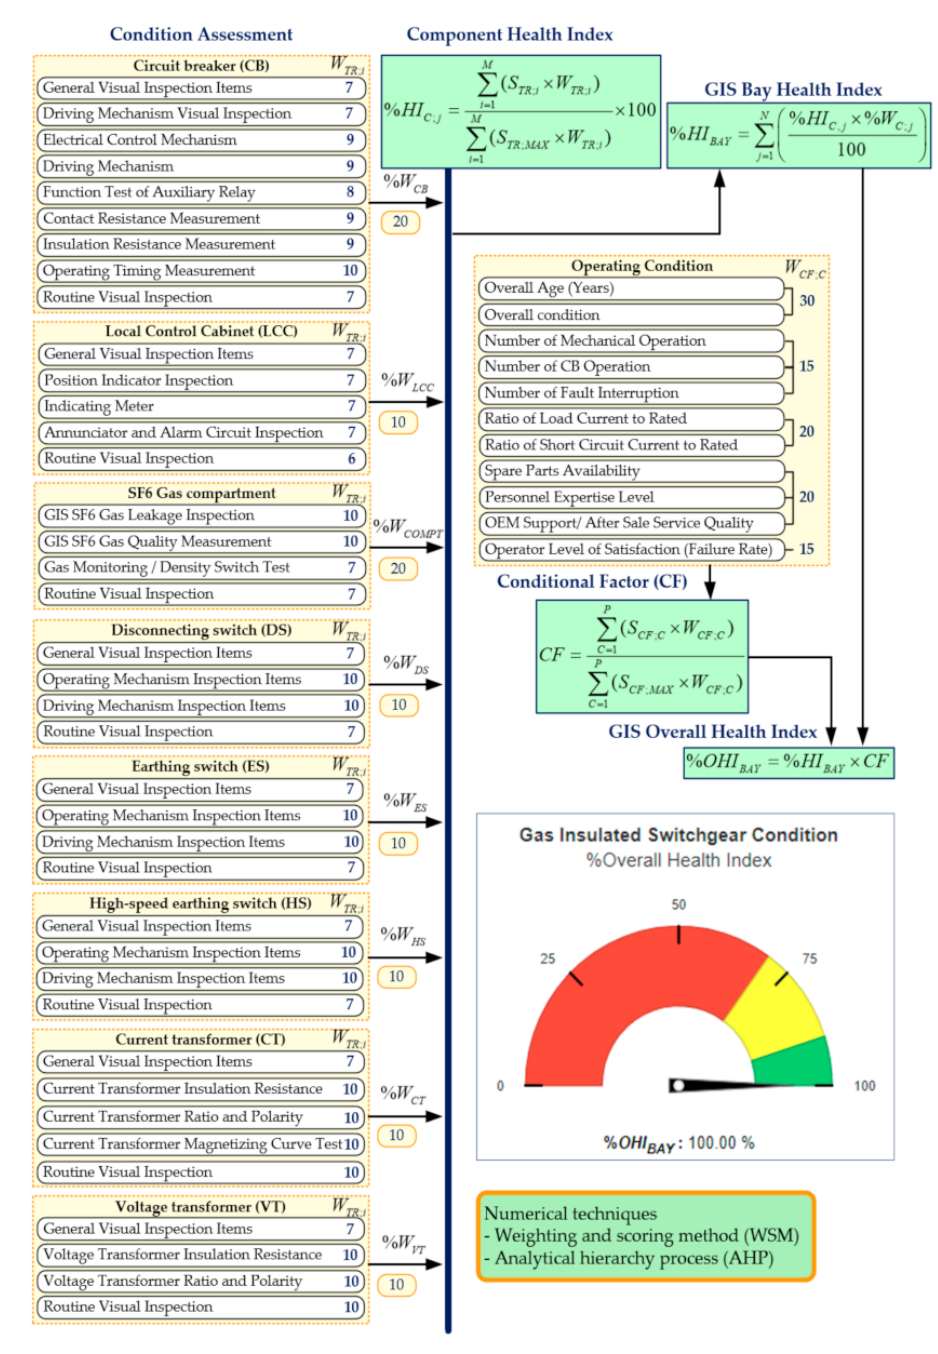
Figure 4. Gas insulated switchgear condition assessment